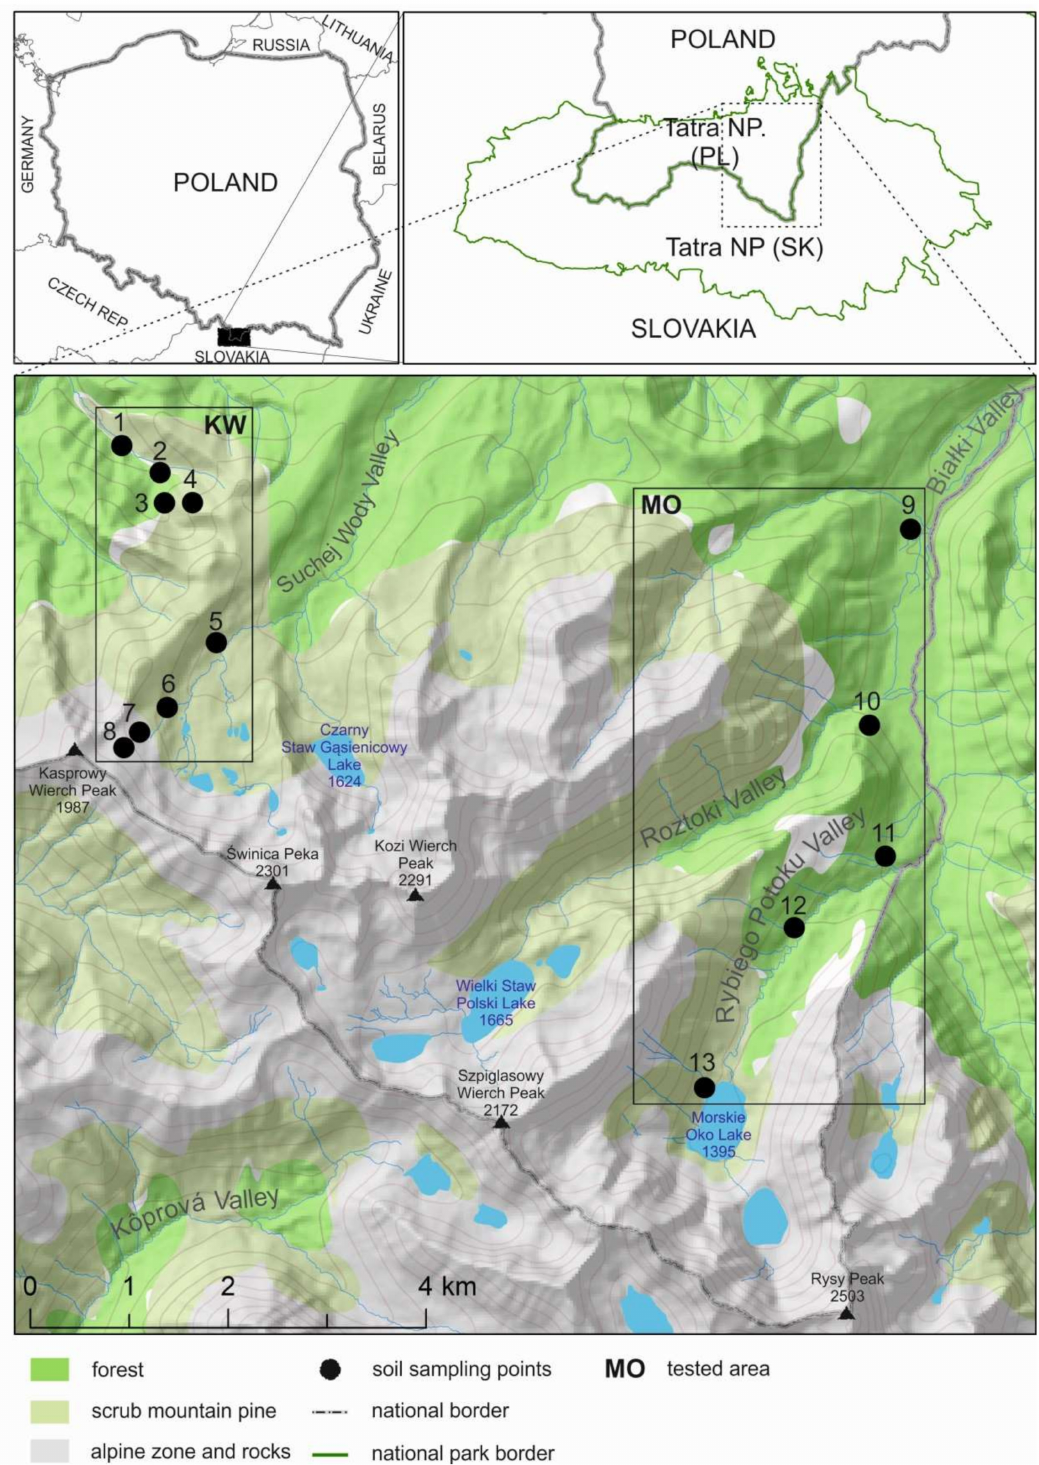
Figure 1. Location of the tested area on the background of the map of Poland and Tatra National